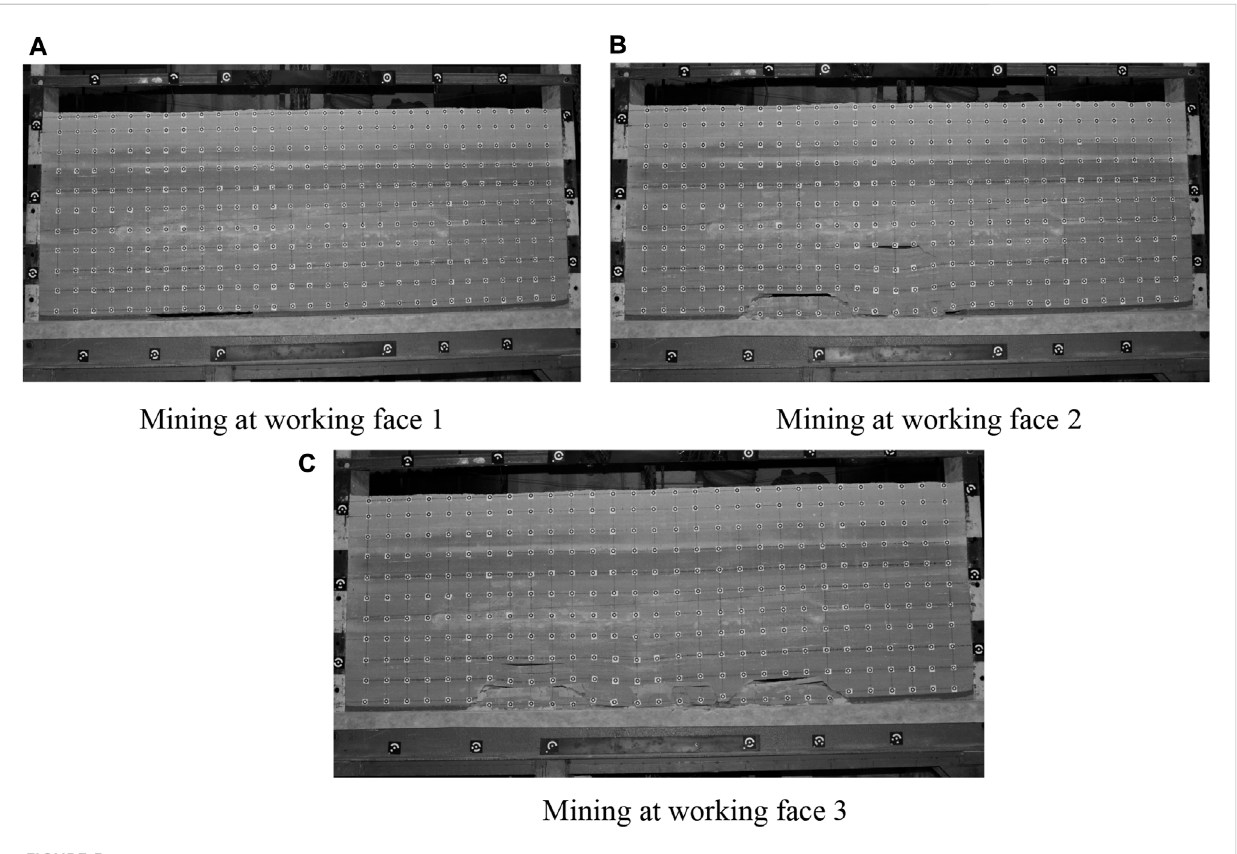
FIGURE 5 Photos of the mining process. (A) Mining at working face 1 (B) Mining at working face 2 (C) Mining at working face 3.